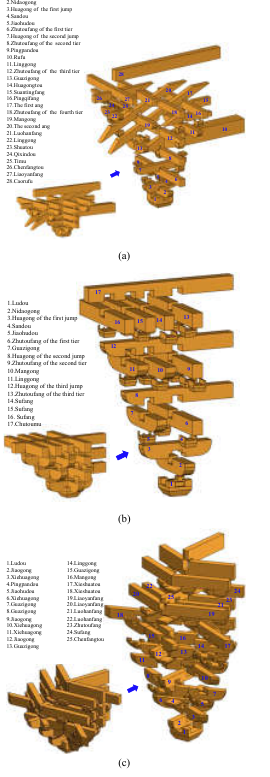
Figure 3. Overall diagram and disassembly diagram of three selected Dou-Gong; (a) Zhutou Puzuo; (b) Bujian Puzuo; (c) Zhuanjiao Puzuo. The corresponding name and configuration are presented in